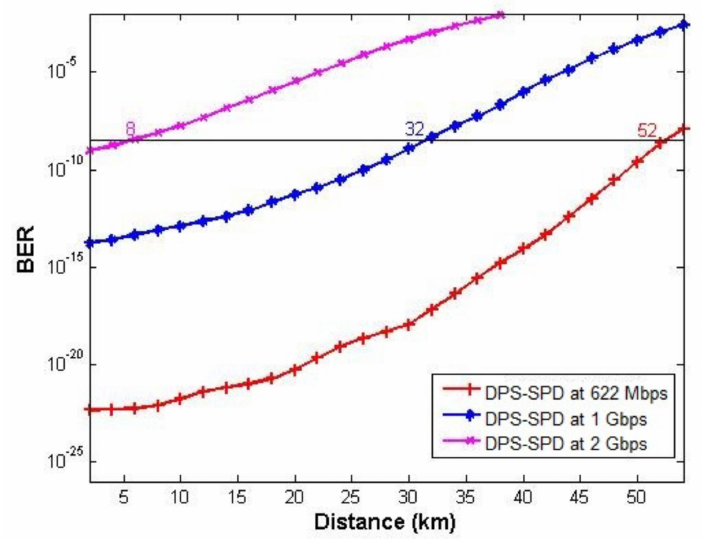
Figure 8. BER versus transmission distance for DPS code using SPD detection scheme at 622 Mbps, 1 Gbps, and 2